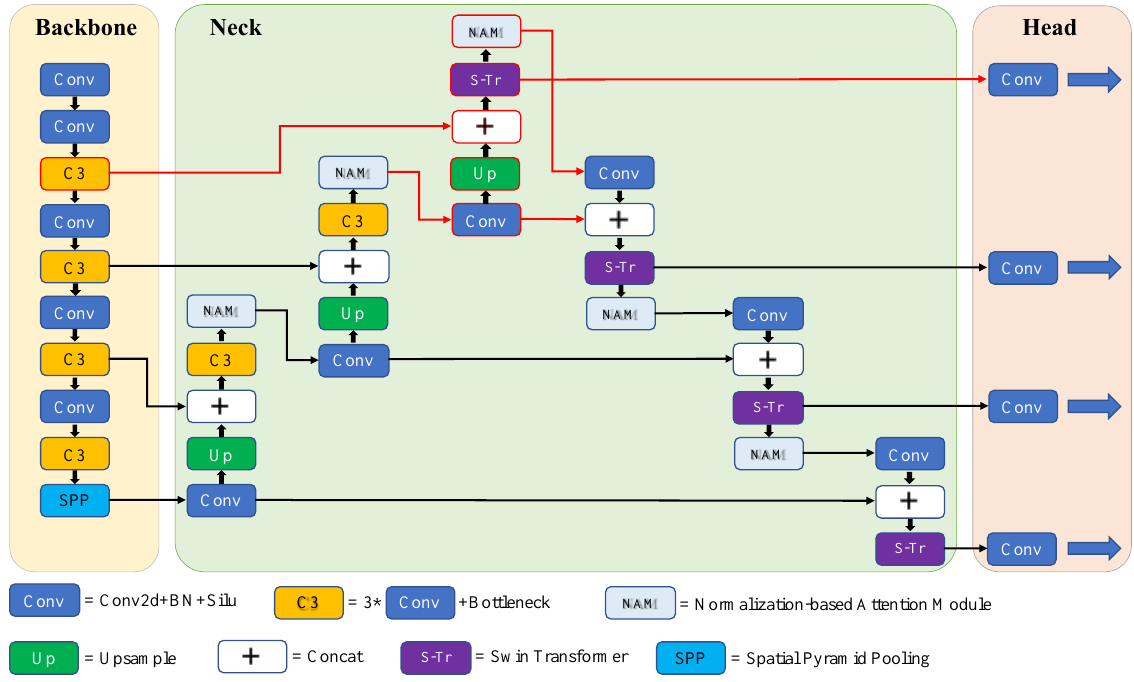
Figure 1. The architecture of SPH-YOLOv5. The red lines and boxes represent the added residual connections and feature fusion layers, respectively, compared to the original version. We also added five NAM modules and four Swin transformer encoders to improve performance.